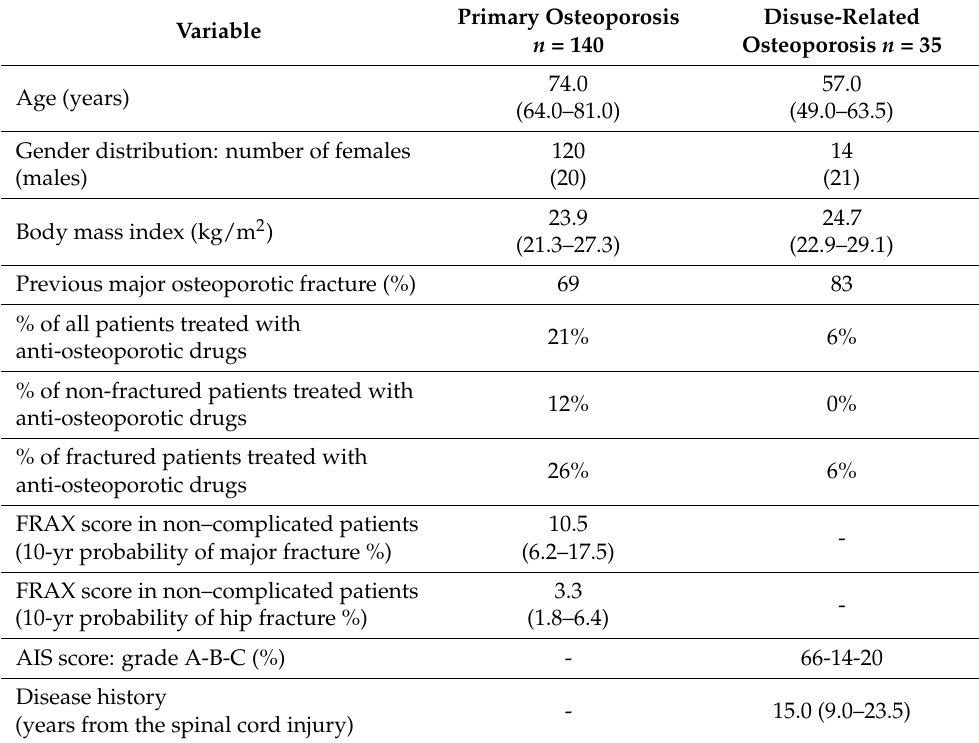
Table 1. Clinical characteristics of two groups of patients. Data are reported and median (1st–3rd quartile). AIS: American spinal injury association Impairment